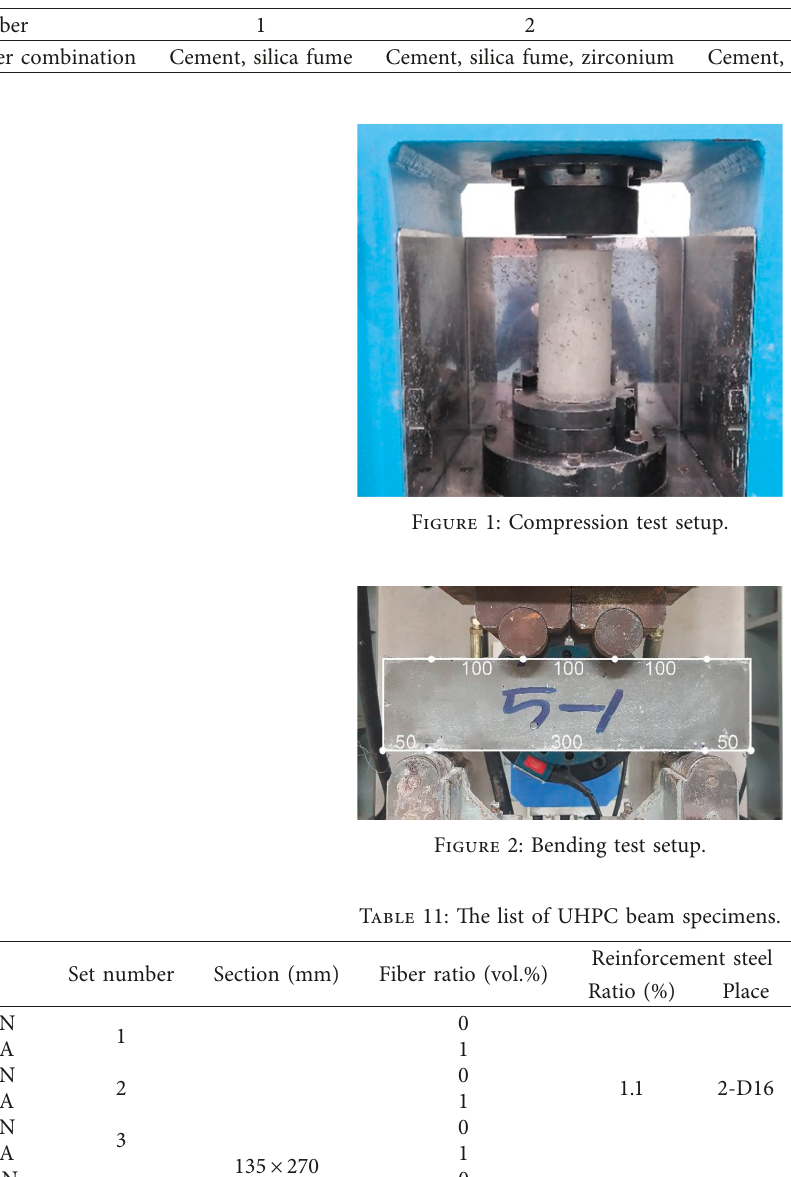
Table 10: Binder combinations for compression testing.